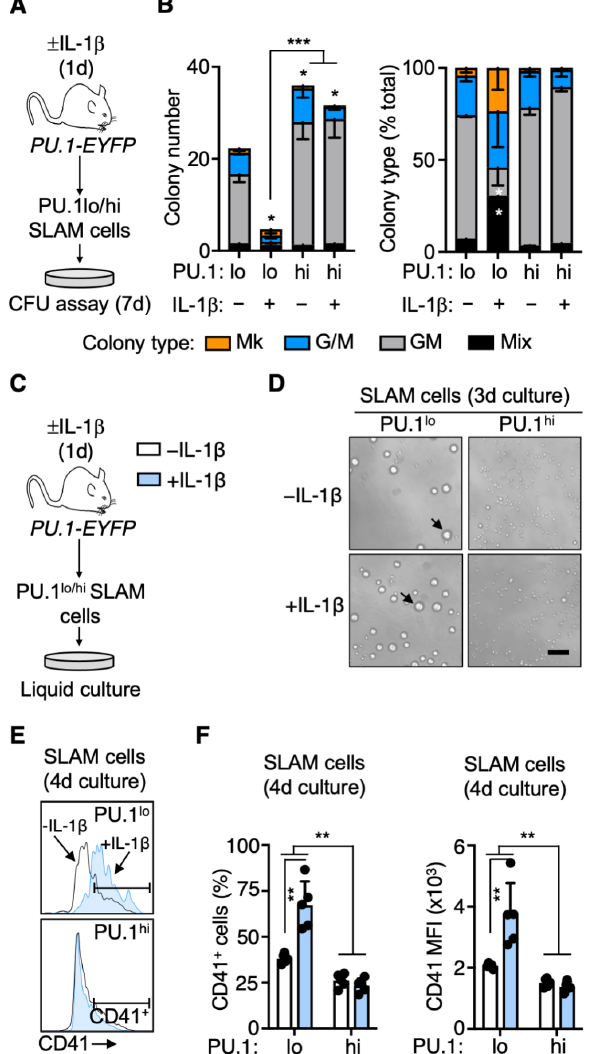
Figure 5. PU.1 lo SLAM cells from IL-1 β -treated mice exhibit characteristics of SL-MkP. ( A ) Experimental design for in vitro methylcellulose culture analysis of PU.1 lo and PU.1 hi SLAM cells from PU.1-EYFP mice treated for 1 d IL-1 β ( n = 3/grp). ( B ) Colony number (left) and colony type distribution (right) of methylcellulose-cultured PU.1 lo and PU.1 hi SLAM cells from PU.1-EYFP mice treated for 1 d IL-1 β ( n = 3/grp). Colony types were based on visual scoring. Colony type distribution is expressed as % total colonies. Data are representative of two independent experiments. Mk: megakaryocytic; G/M. ( C ) Experimental design for in vitro liquid culture analysis of PU.1 lo and PU.1 hi SLAM cells from PU.1-EYFP mice treated for 1 d IL-1 β ( n = 5/grp). ( D ) Representative phase- contrast microscope images after 3-day culture of PU.1 lo and PU.1 hi SLAM cells from PU.1-EYFP mice treated for 1 d IL-1 β . Scale bar: 100 µ m. Arrows indicate Mk-progenitor-like cells. ( E ) Representative histograms of CD41 expression after 4-day culture of PU.1 lo and PU.1 hi SLAM cells from PU.1-EYFP mice treated for 1 d IL-1 β . ( F ) Summary data showing frequency of CD41+ cells (left) and overall CD41 expression levels (right) after 4-day culture of PU.1 lo and PU.1 hi SLAM cells from PU.1-EYFP mice treated for 1 d IL-1 β ( n = 5/grp). Expression data are geometric mean fluorescence intensity (MFI). Individual values are shown, and bars represent mean values. Data are representative of two independent experiments. Data are shown as means SD. Significance was determined by ANOVA with Tukey’s post-test. * p < 0.05; ** p < 0.01. *** p < 0.001. The lack of clonogenic activity in PU.1 lo SLAM cells from IL-1 β -treated mice raised the question as to whether this compartment might be enriched for stem-cell-like